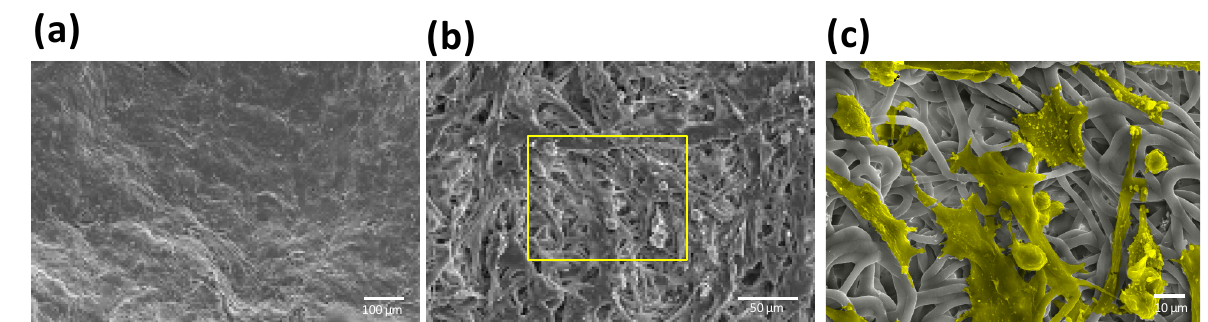
Figure 5. SEM images of U-251 MG culture on fibronectin coating nanofiber-mâché ball for 72 h. ( a ) Cells adhered to the inner surface, where the fibers were randomly oriented, at low magnification observation. ( b ) The adhesivity of uniform cells onto the inner surface ( c ) contributed to forming an adepithelial layer, at two magnifications. (Yellow in false-color image: